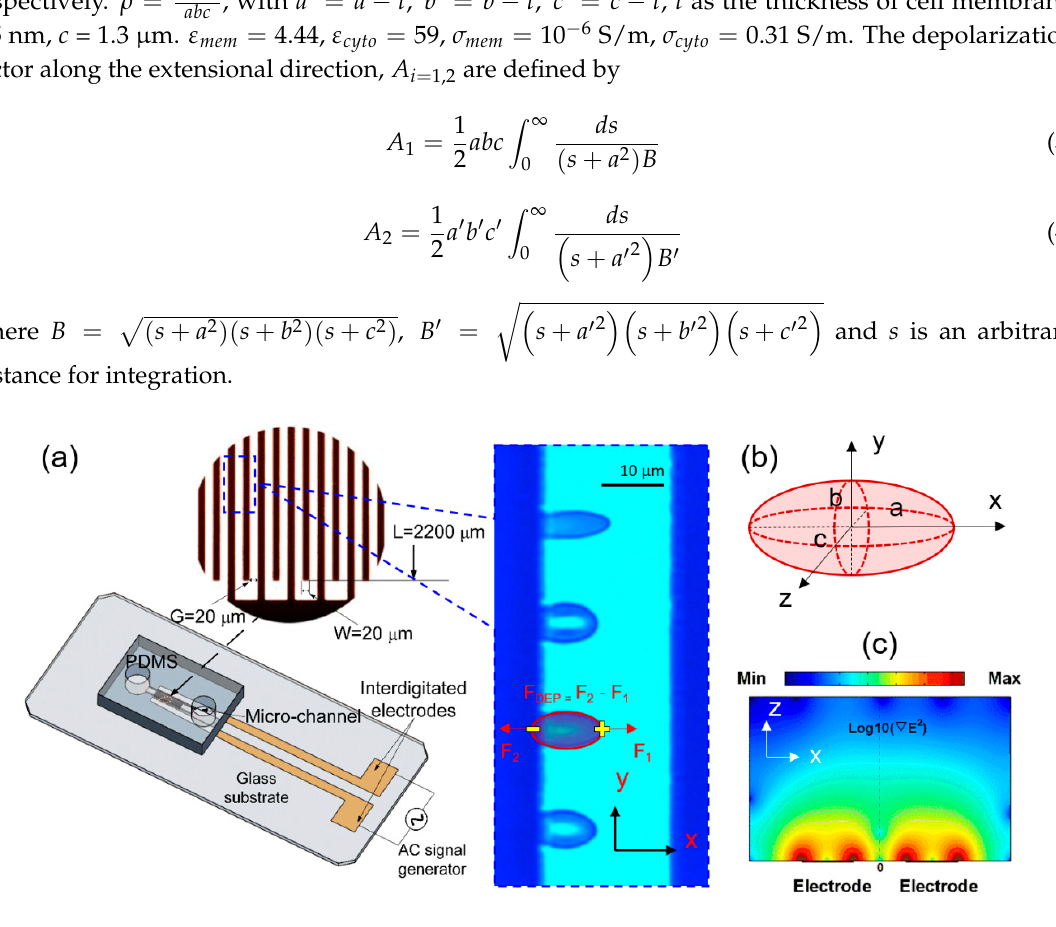
Figure 1. Biomechanics testing of live cells using dielectrophoresis (DEP) in microfluidics. ( a ) Microfluidic device with inset of microscopic view of cellular deformation. Dark strips represent interdigitated electrodes. ( b ) A triaxial ellipsoid model for description of positive DEP-induced uniaxial cell deformation. ( c ) Surface plot of the gradient of field strength square, ∇ E 2 rms in the microfluidic device, from simulation by COMSOL Multiphysics (COMSOL, Inc., Burlington, MA, USA).